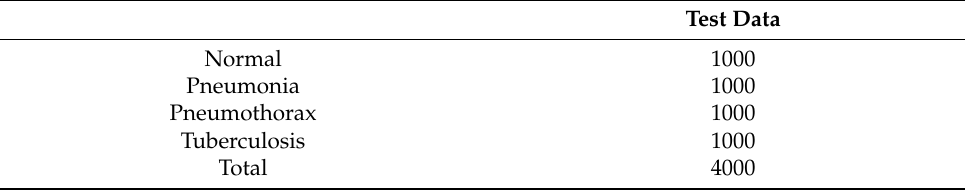
Table 3. SCH test